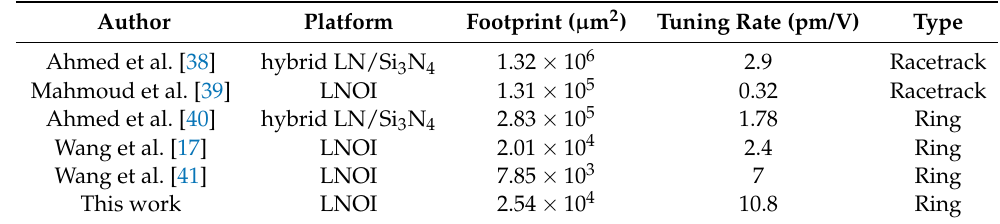
Figure 4. Fitting results for the electro-optical modulation efficiency of the microring resonator, with the red and black lines representing the results of experimental measurement and simulation, respectively. Table 1. Comparison of the footprint and modulation efficiency of different LN microring